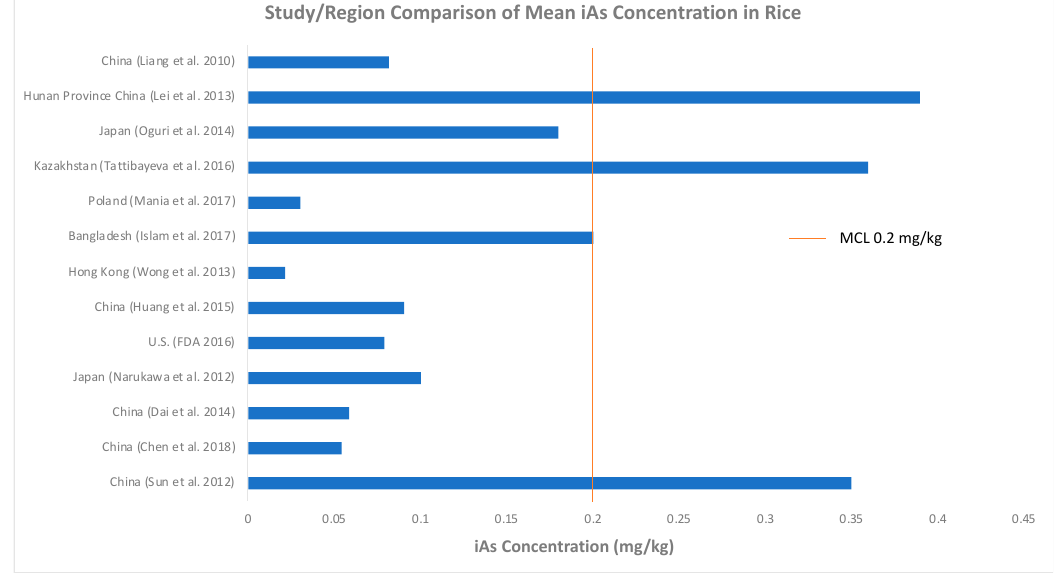
Figure 2. Comparison of iAs concentrations in rice in different studies and regions.